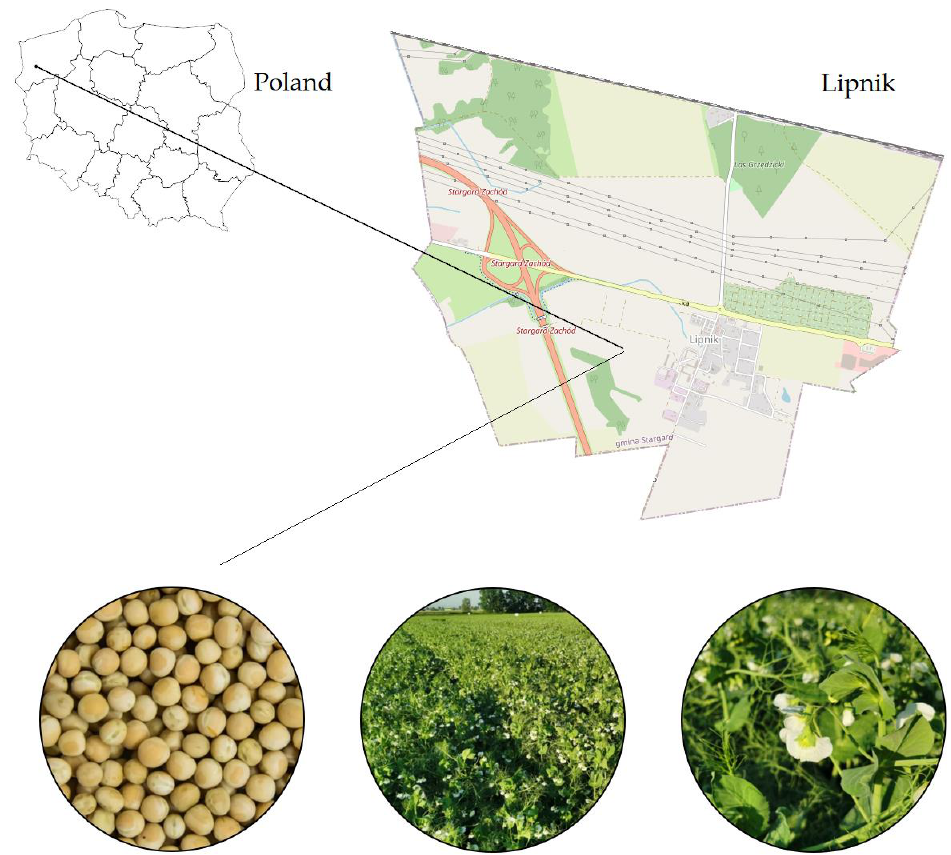
Figure 1. The map of the collection region.